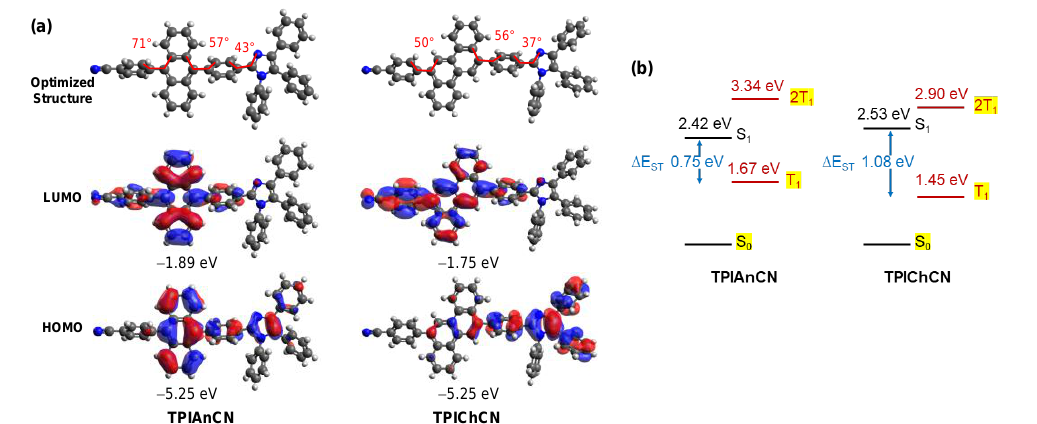
Figure 2. ( a ) The optimized structures, HOMO/LUMOs distribution, and energy levels calculated by B3LYP/6 – 31G(d,p) method in the gas phase. ( b ) The energy diagrams of the singlet (S) and triplet (T) excited states computed by TD-DFT B3LYP/6 – 31G(d,p) method.